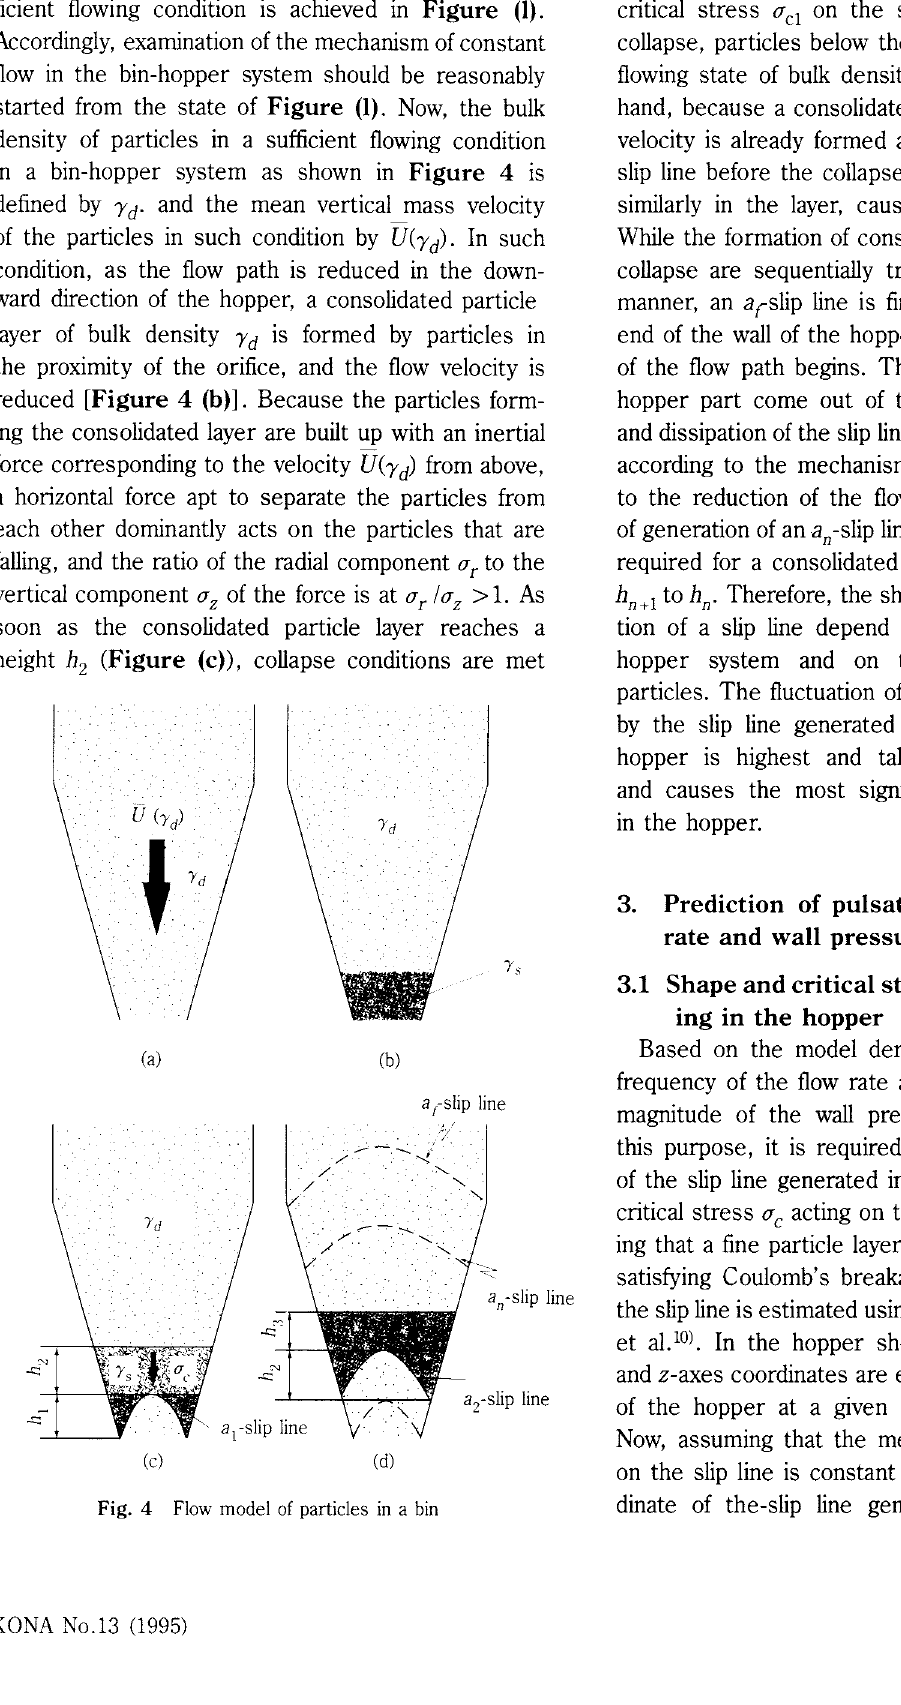
Fig. 4 Flow model of particles in a bin